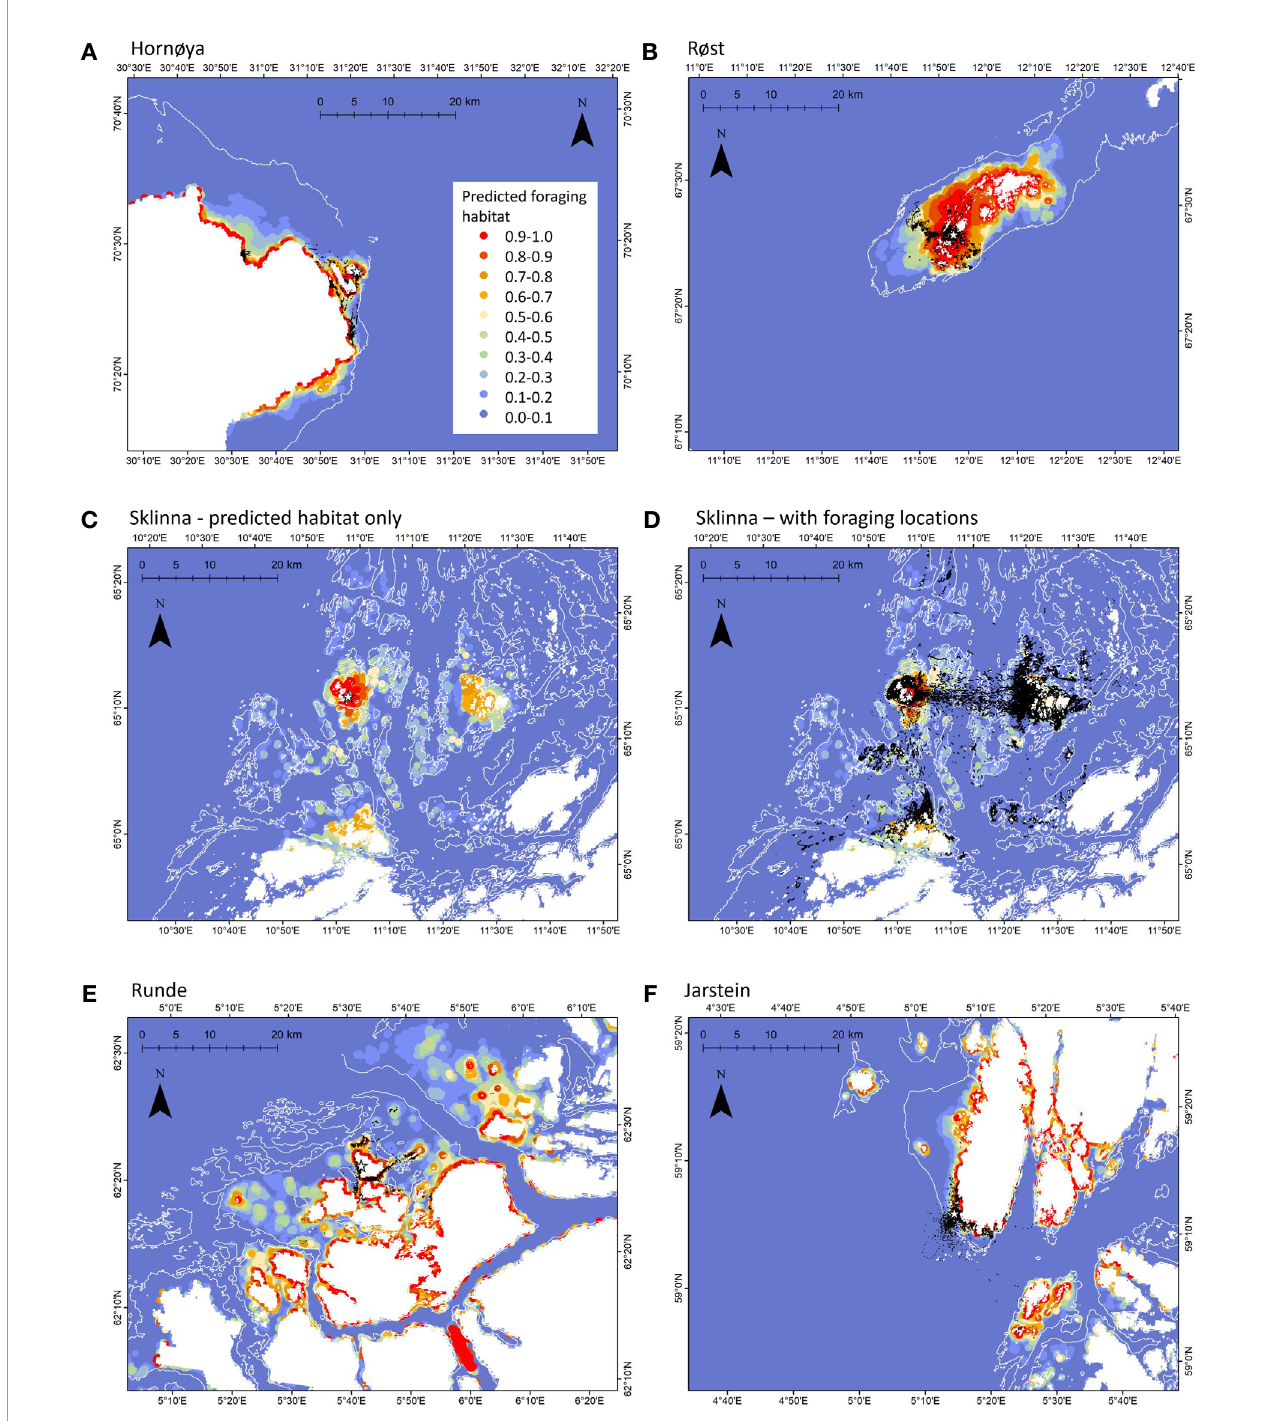
FIGURE 4 | Predicted habitat maps based on the “ all colonies approach ” models, i.e. data from all other colonies and years was used to predict the foraging habitat around the shown (focal) colony. The location of the colony is marked with a white star. The probability for the area to be used as foraging habitat is shown in colours from blue (low) to red (high), as detailed in the legend. White lines show the 100m bathymetry line, land areas are depicted in white. Foraging locations based on the EMBC algorithm are shown as black dots (A, B, D – F) . Due to the high data amount, foraging locations for Sklinna are shown in a separate plot (D) than the predicted foraging habitat (C)